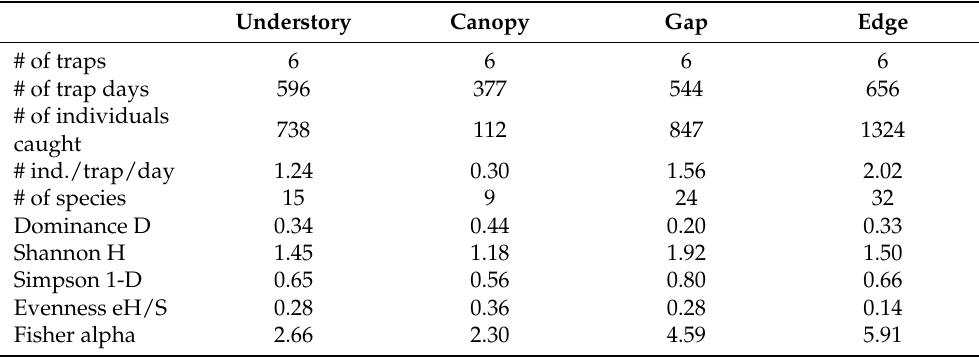
Table 1. Trapping effort, abundances, and diversity indices for butterflies trapped in fruit-baited traps in the Silent Valley National Park of the Western Ghats, India. Understory Canopy Gap